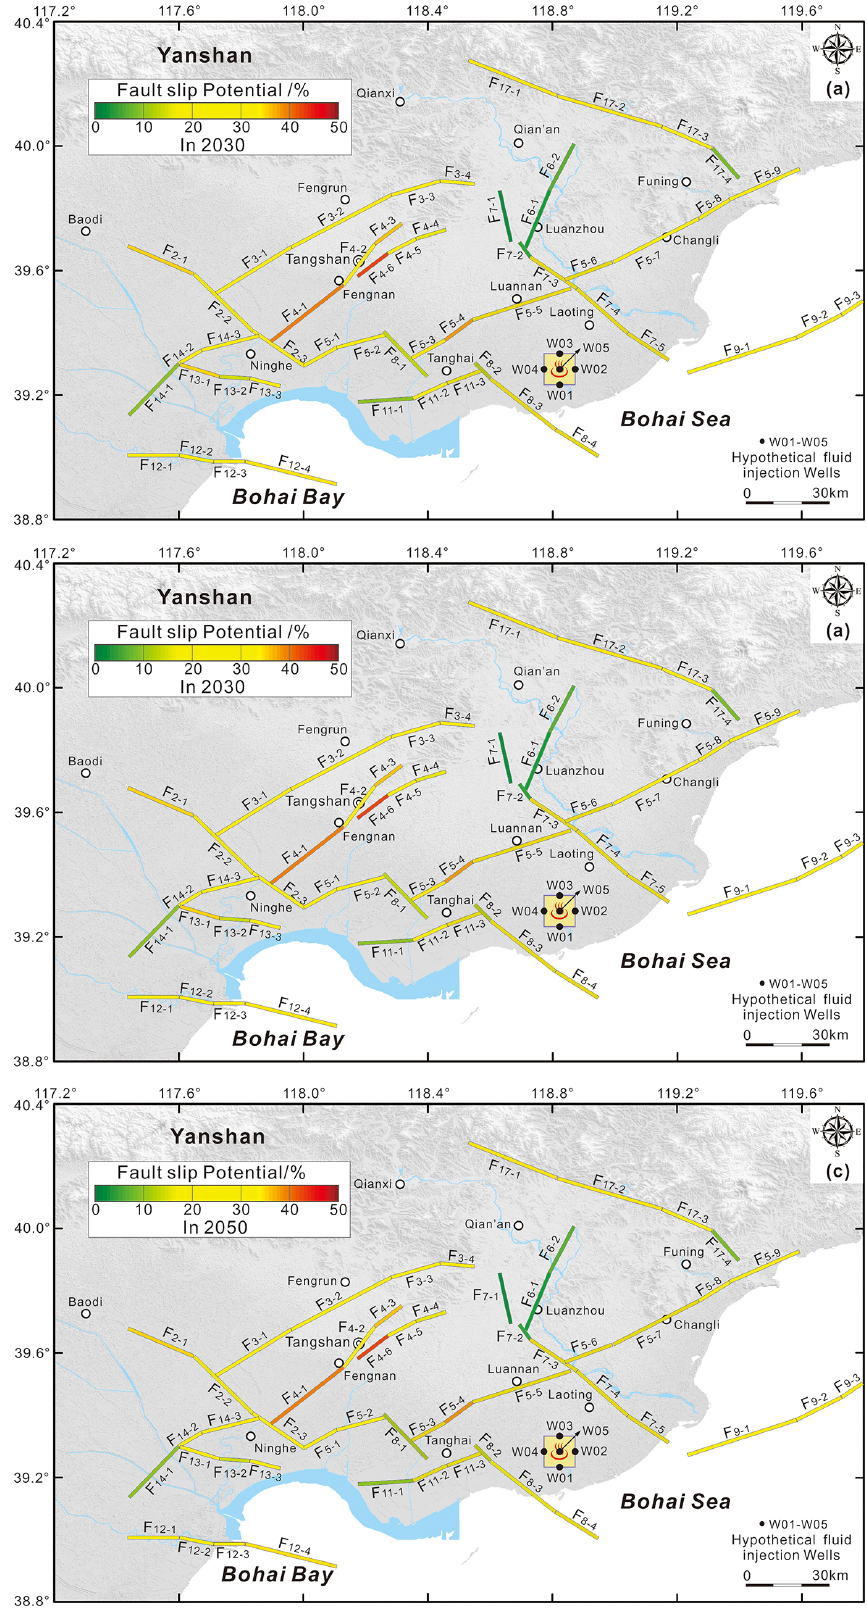
Figure 10. The probabilistic fault slip potential on the mapped faults in response to the hypothetic fluid injection in the MTY EGS field in 2030 (a) , 2040 (b) , and 2050 (c)